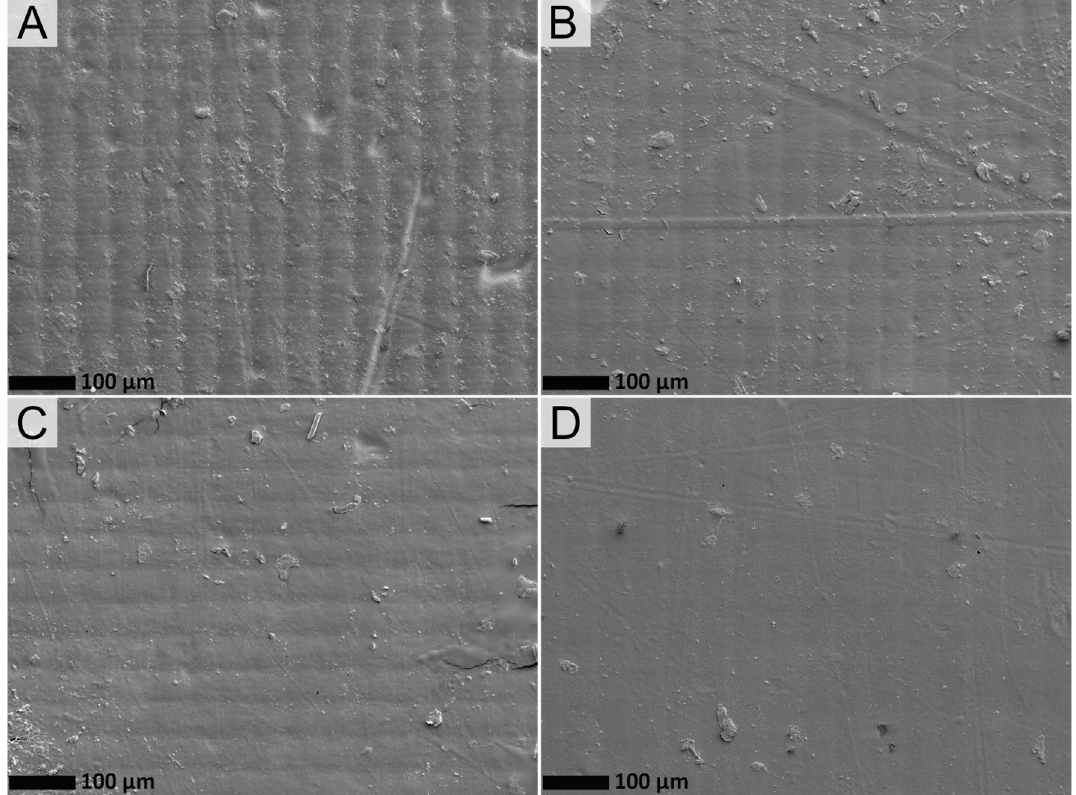
Figure 3. Representative SEM images of the films surfaces of ( A ) LG0, ( B ) LG1, ( C ) LG2, and ( D ) LG35 with a magnitude amplification of 500×. ( D ) LG35 with a magnitude amplification of 500 ×